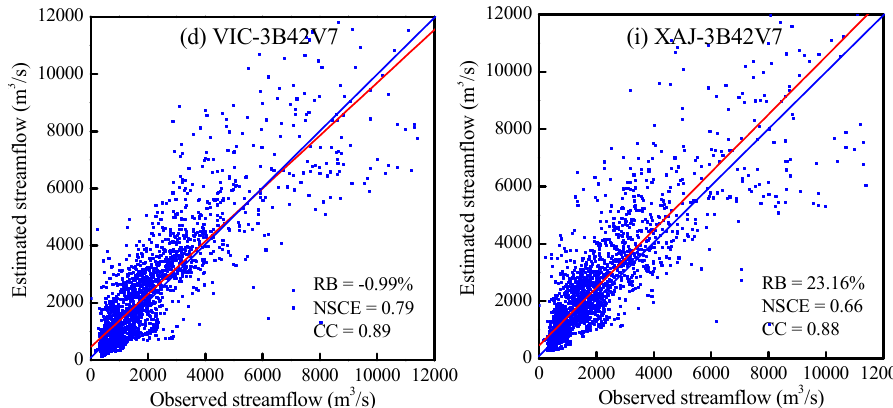
Figure 8. Scatter plots of the observed and simulated streamflow by using VIC and XAJ hydrological models in the Ganjiang River basin (( a – d ) VIC; ( f – i ) XAJ).